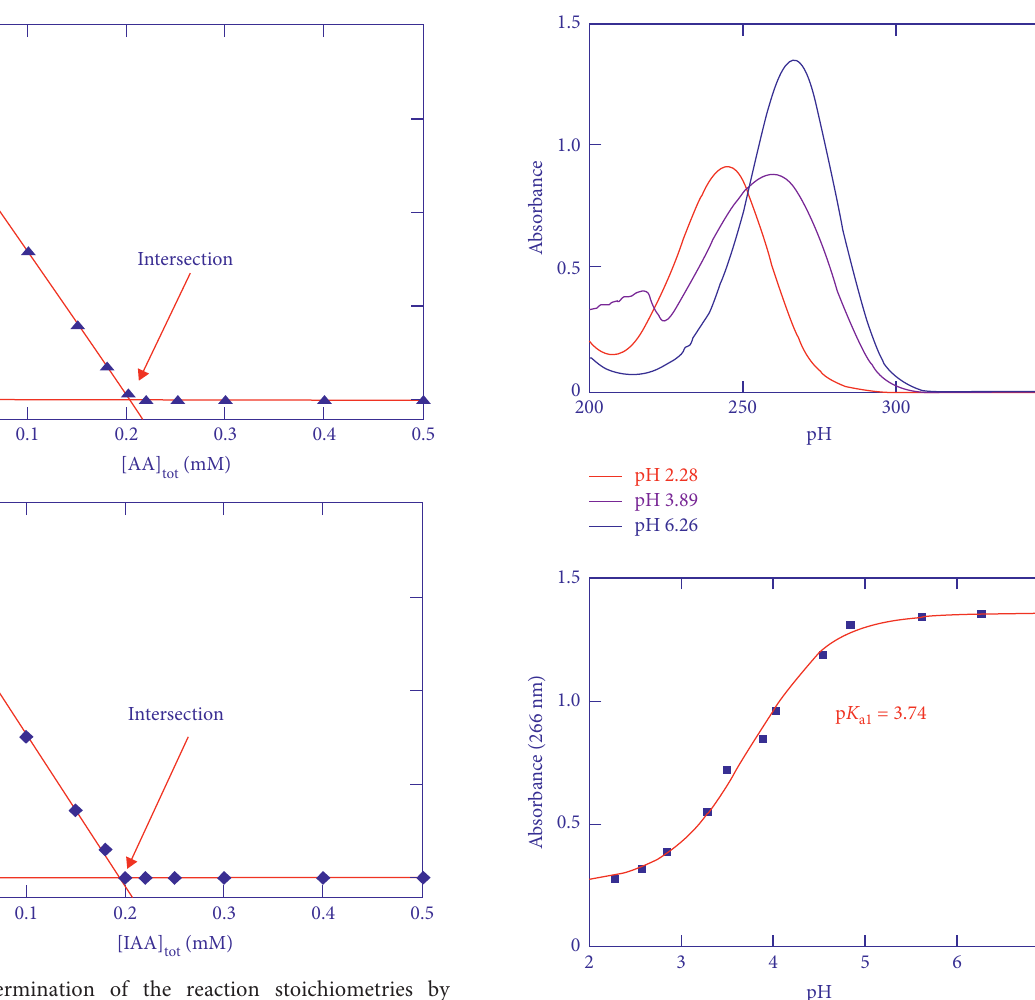
Figure 5: Determination of the reaction stoichiometries by spectrophotometric titrations for reduction of [IrCl 6 ] 2– by AA and IAA. Absorbance at 488nm versus [AA] tot or [IAA] tot for a series of reaction mixtures in which [Ir(IV)] � 0.40mM kept constant and [AA] tot or [IAA] tot varied from 0 to 0.50 mM. Reaction medium: [H + ] � 0.10M and 1.0M ionic strength; reaction time is about 5min, room temperature.